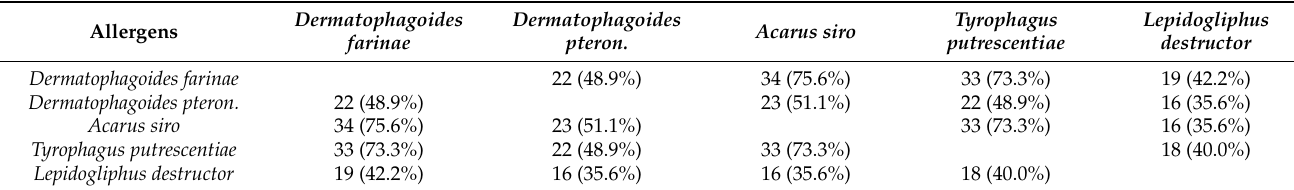
Table 3. Number and (%) of co-positives in the category of mites in IN positive subjects ( n = 45) with CAD. Dermatophagoides Dermatophagoides Allergens farinae pteron. Dermatophagoides farinae